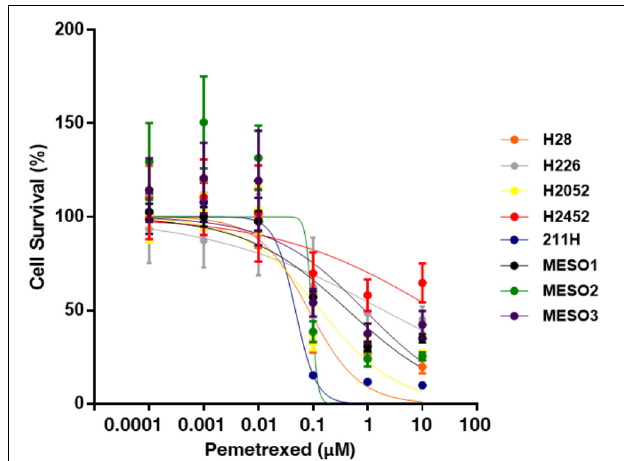
FIGURE 1 | Pemetrexed treatment represses cell growth of MPM cells. WST-8 assay with pemetrexed. Cells were treated with the indicated concentration of pemetrexed for 72 h, and their viability was assessed by the WST-8 assay. The % viability data are shown as the mean ± standard deviation (SD) ( n = 6). Error bars indicates the range of SD. Blue line: MSTO-211H, Orange line: NCI-H28, Gray line: NCI-H226, Yellow line: NCI-H2052, Red line: NCI-H2452, Black line: TCC-MESO1, Green line: TCC-MESO2, and Purple line: TCC-MESO3. The in vitro half maximal inhibitory concentration (IC 50 ) of pemetrexed for the growth of MPM cell lines was calculated as the following values for each cell line: NCI-H28 = 84.1 nM, NCI-H226 = 1950 nM, NCI-H2052 = 135 nM, NCI-H2452 = > 10,000 nM, MSTO-211H = 47.4 nM, TCC-MESO1 = 435 nM, TCC-MESO2 = 94.3 nM, and TCC-MESO3 = 883